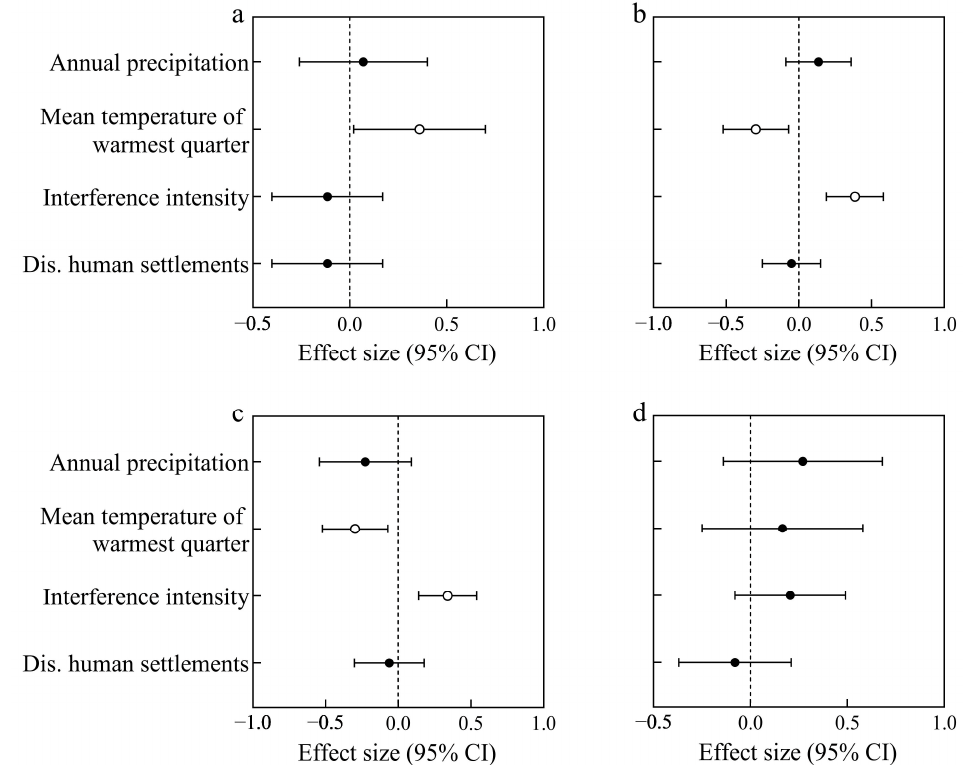
Figure 6. Effect values of human activities and climatic factors on ( a ) native herbs, ( b ) all invasive alien herbs, and ( c ) new and ( d ) old invasive alien herbs. Hollow circles represent species richness significantly correlated with environmental factors, solid circles represent species richness not significantly correlated with environmental factors, and dashed lines indicate an effect value of 0.